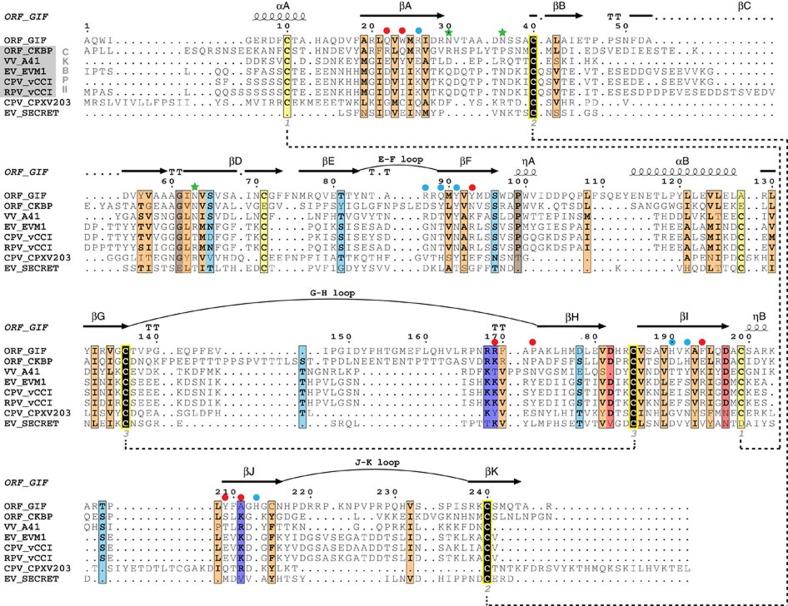
Sequence alignment of Orf GIF and members of the Poxviral Immune Evasion (PIE) family.Structural alignment performed by Expresso76 and visualized by ESPript77. Used sequences include Orf virus (ORF) CKBP, vaccinia virus (VV) A41, ectromelia virus (EV) vCCI (EVM1), cowpox virus (CPV) VCCI, rabbitpox virus (RPV) vCCI, cowpox virus (CPV) CPXV203 and ectromelia virus (EV) SECRET domain of CrmD. Conserved negatively and positively charged residues are shown in red and blue respectively, conserved polar residues are shown in light blue and conserved hydrophobic residues are shown in orange. Fully conserved residues are coloured black, with a yellow outline for cysteine. Conserved disulfide bonds are shown as connecting dashed lines. Secondary structure elements in GIF are annotated above the corresponding sequences. Residues of GIF involved in interactions with GM-CSF are shown as circles (red: interaction with helix αA, blue: interaction with helix αD of GM-CSF), whereas N-linked glycosylation sites in GIF are marked with a green star.